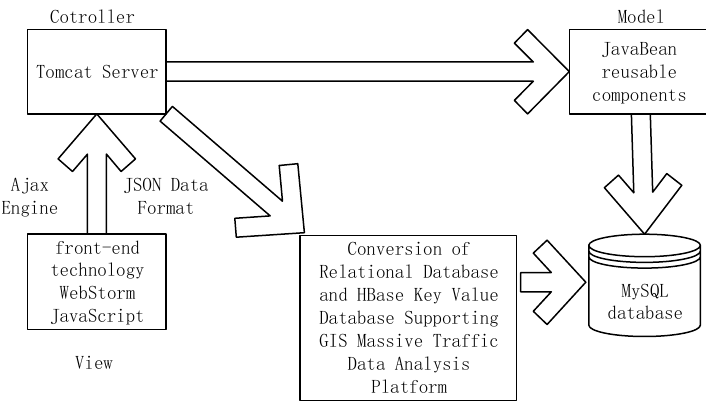
Figure 3. Technical architecture of GIS mass traffic data analysis platform based on